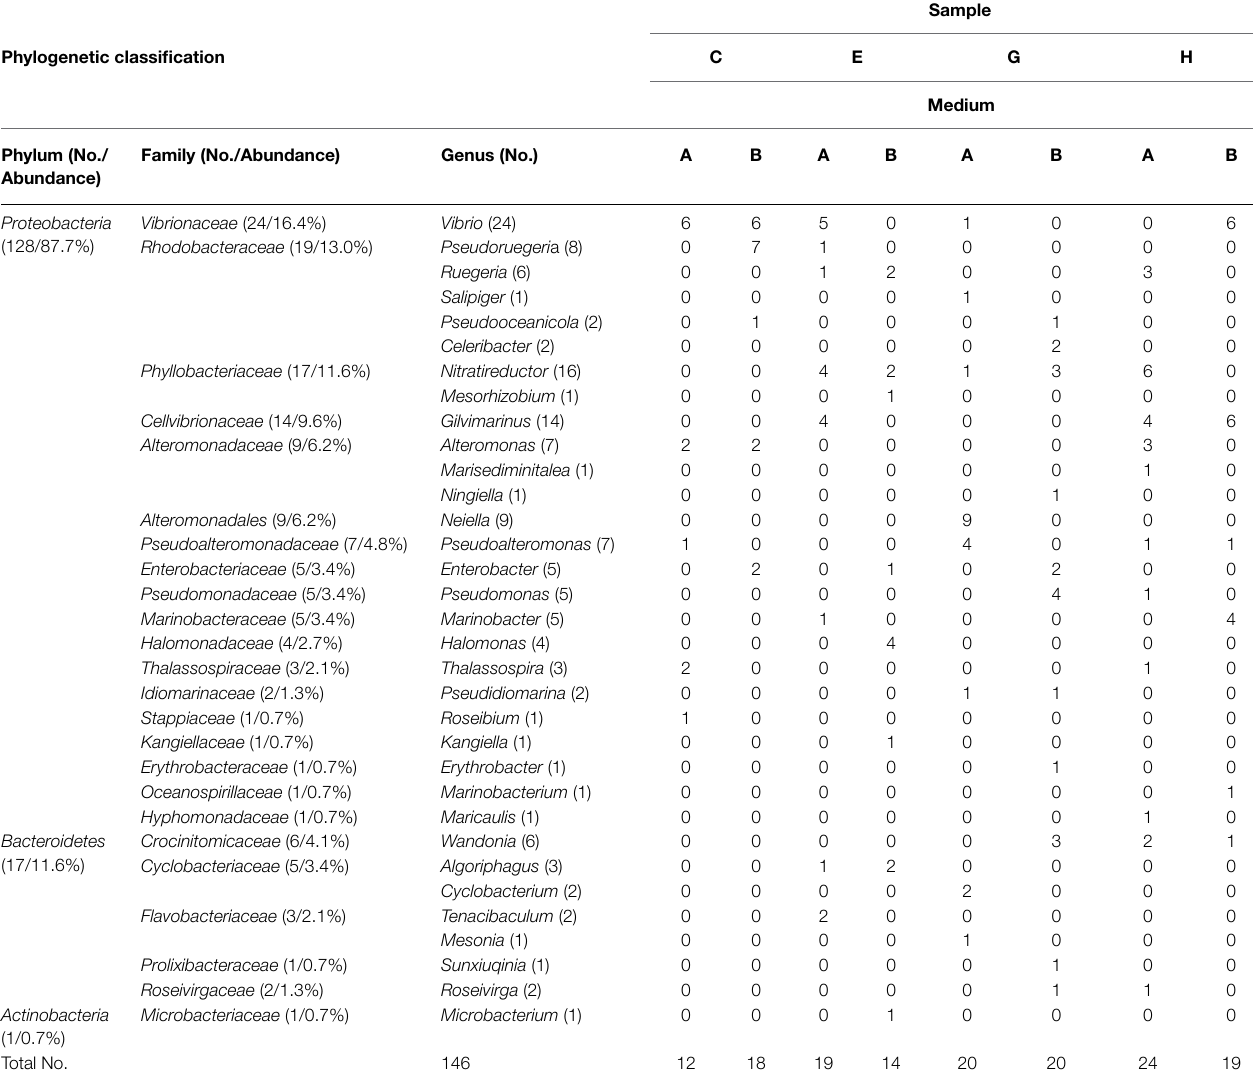
TABLE 2 | Phylogenetic classification and relative abundance of culturable bacteria isolated from the enrichment cultures of the algal samples a .